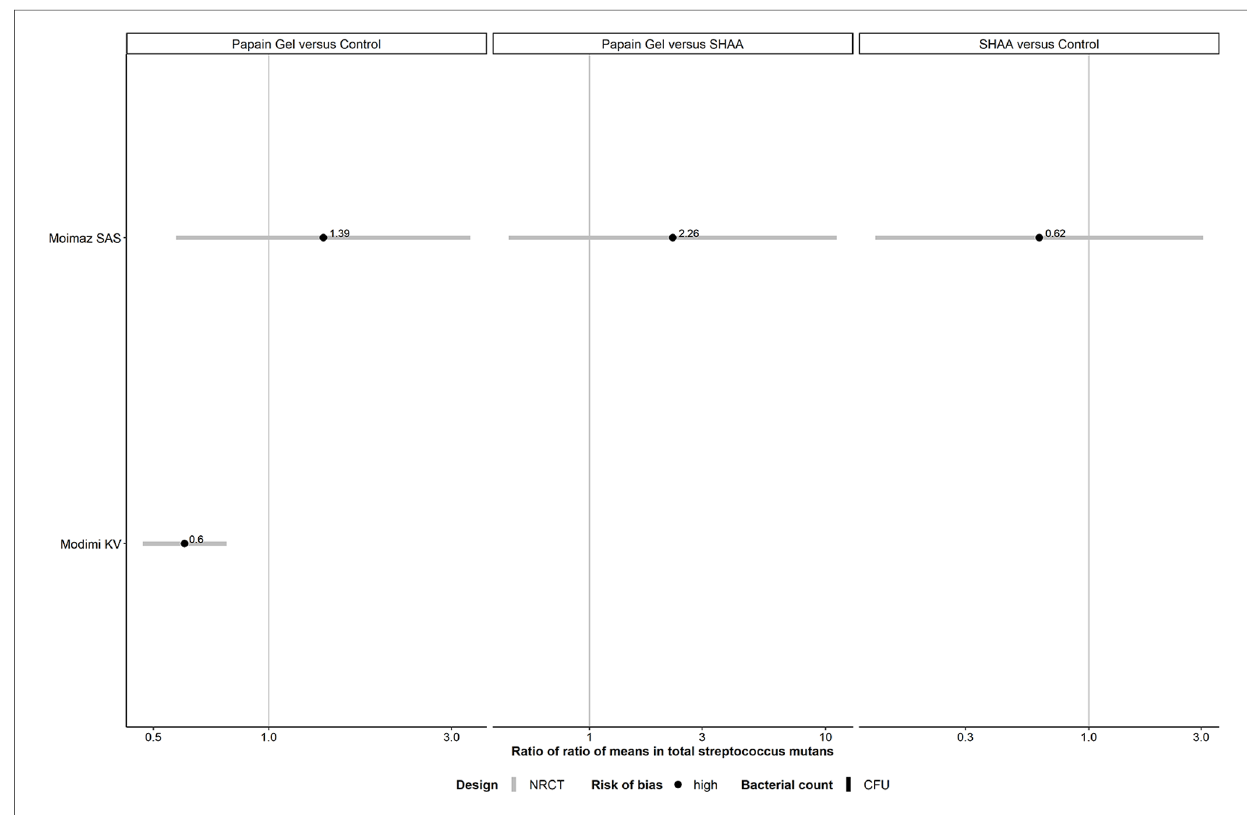
FIGURE 8 Forest plots showing roRoMs for Streptococcus mutans across chemomechanical